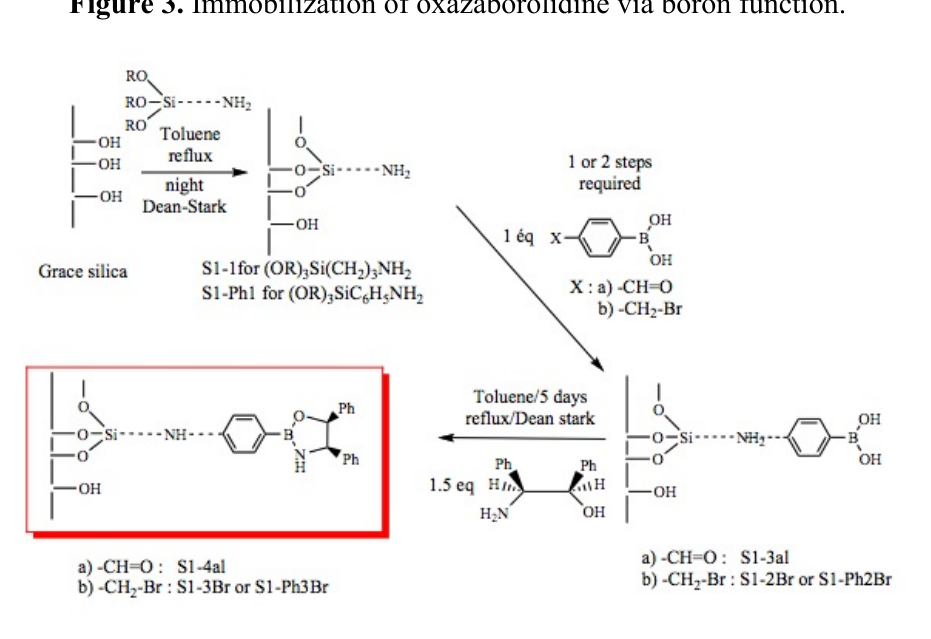
Figure 3. Immobilization of oxazaborolidine via boron function.